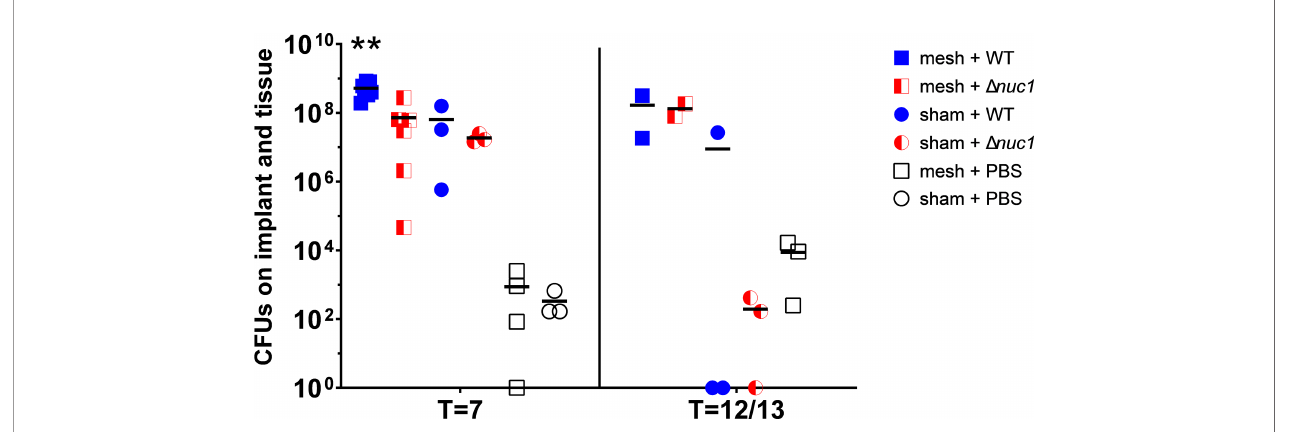
FIGURE 2 | Total CFUs in mesh-tissue samples taken after termination of mice inoculated with either S. aureus Newman WT lux (WT) or S. aureus Newman D nuc1 lux ( D nuc1 ) strains or injected with sterile PBS after 7 days or after 12 or 13 days post implantation (two measurements were taken at T=12, and the other at T=13 days) of PVDF surgical mesh implant. Horizontal bar represents the geometric mean value. **Indicates signi fi cant difference between mesh + WT and all other groups at the same timepoint (P <